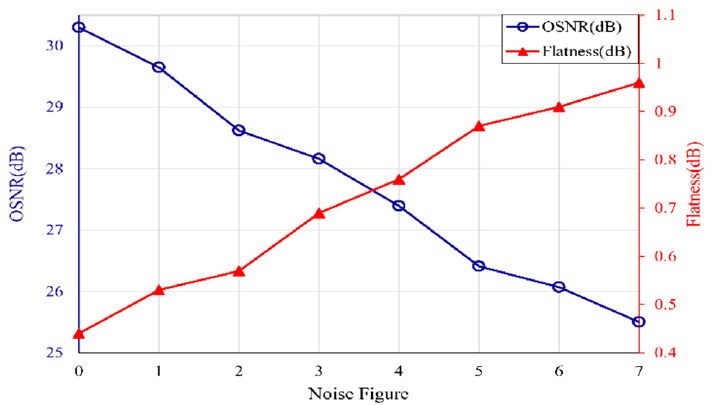
Figure 6. Effect of noise figure on the OSNR and flatness of optical frequency comb.